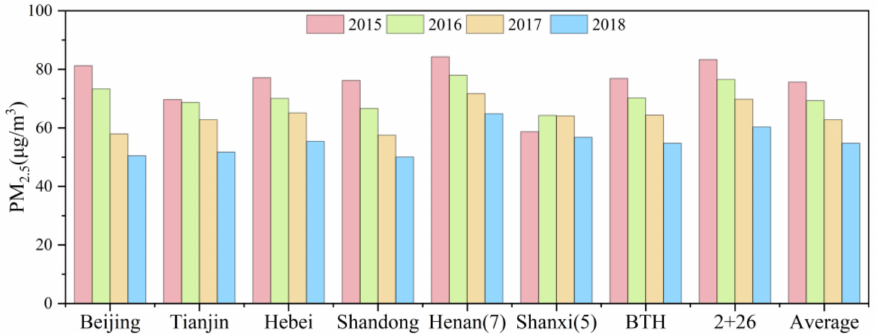
Figure 2. Average PM 2.5 concentrations in the different sub-regions of NNCP